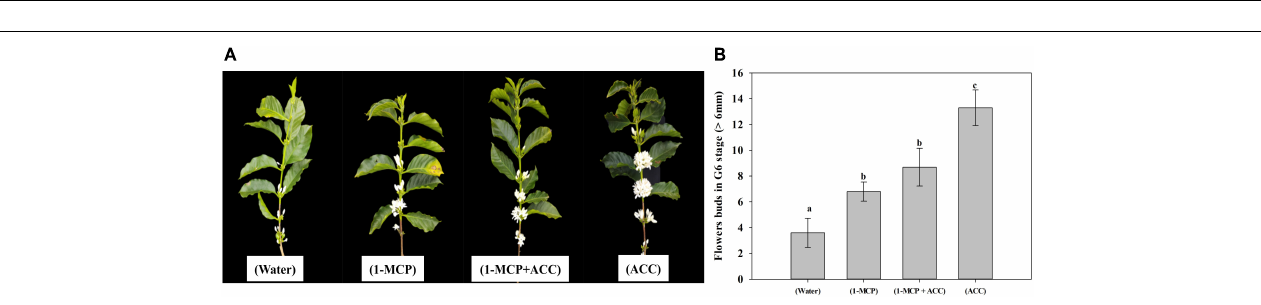
FIGURE 5 | Effect of ACC treatment in coffee anthesis. (A) Branches with the opened flower as effect different treatments. (B) Statistical differences among treatments with the application of exogenous ACC and other treatments in flower buds at G6